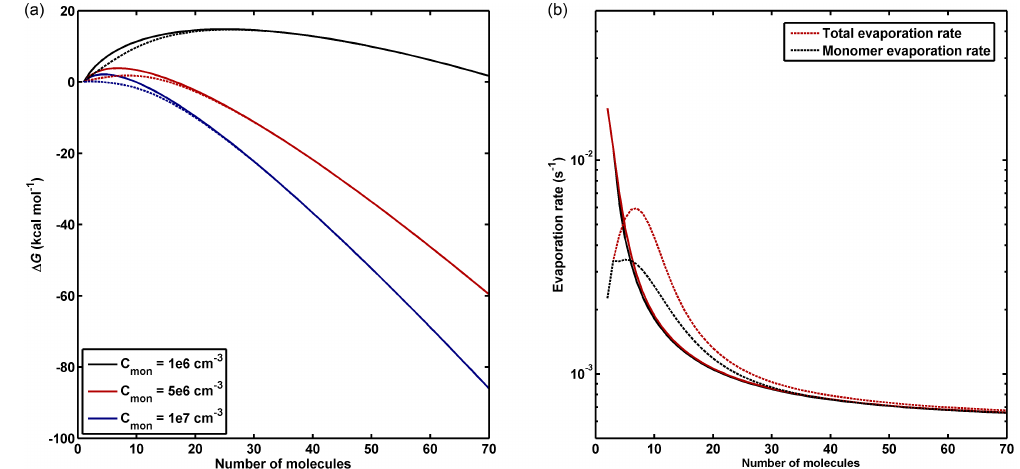
Figure A1. (a) The classical Gibbs free energy profile with one maximum and no minima (solid lines) and with an additional negative term corresponding to the stabilization of the smallest clusters (dashed lines) at different steady-state monomer concentrations (shown as different colors). (b) Evaporation profiles corresponding to the two Gibbs free energy profiles (note that the evaporation rate is independent of the vapor concentration).